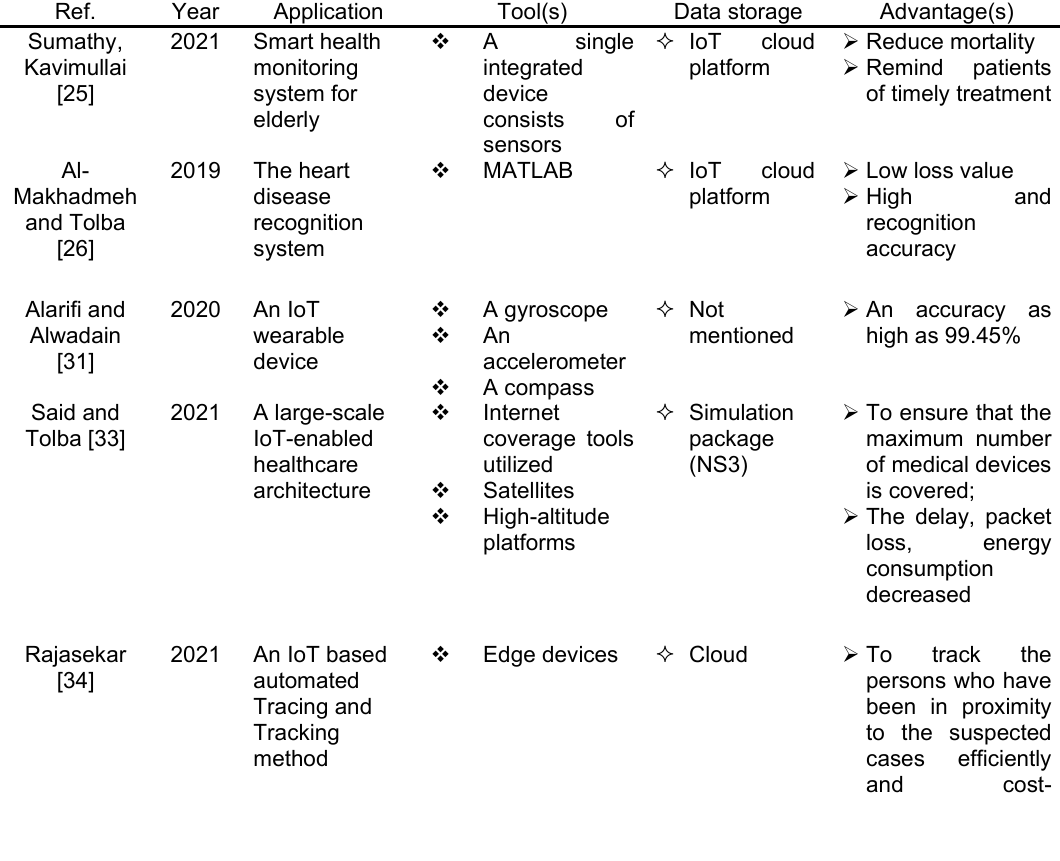
Table 2. A comparison of applications above